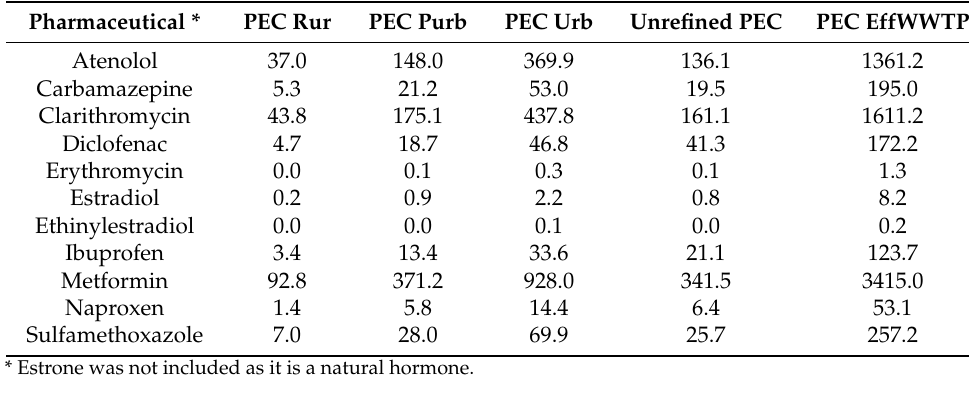
Table 3. Predicted environmental concentration (PEC) of selected pharmaceuticals (ng L − 1 ) in surface waters from rural (PEC Rur), periurban (PEC Purb), and urban (PEC Urb) areas based on the refinement of the formula using the population density of the areas at increasing anthropogenic pressure. For comparison, the unrefined PEC and the PEC of the effluent of the wastewater treatment plant (PEC EffWWTP) are shown.